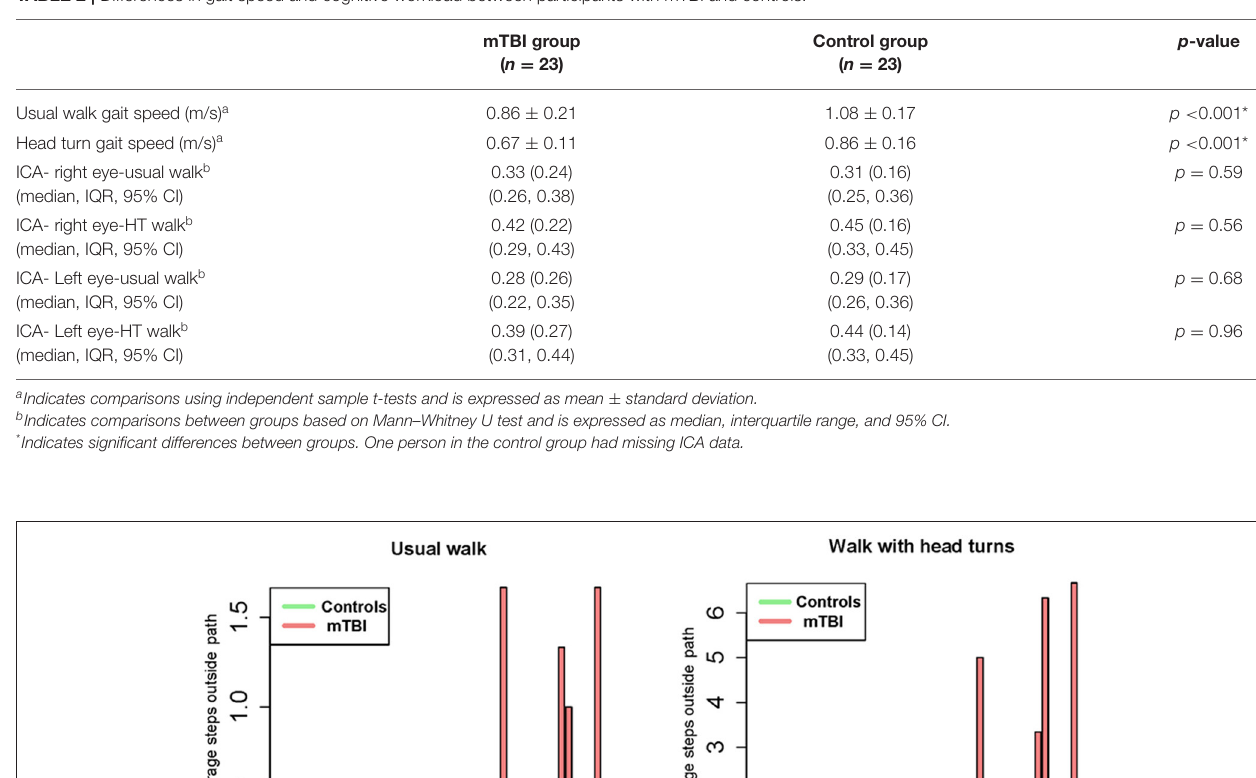
TABLE 2 | Differences in gait speed and cognitive workload between participants with mTBI and controls.